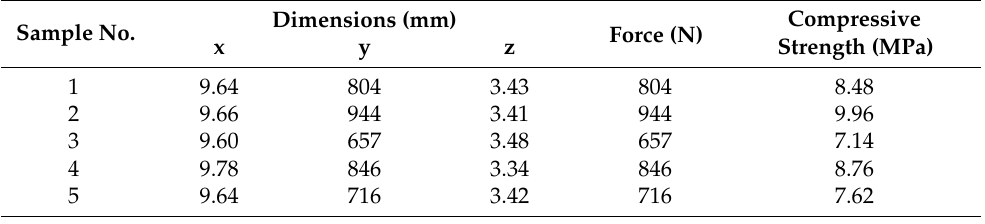
Table 3. Dimensions and compressive strength data for bioactive glass scaffolds sintered at 800 ◦ C. Sample